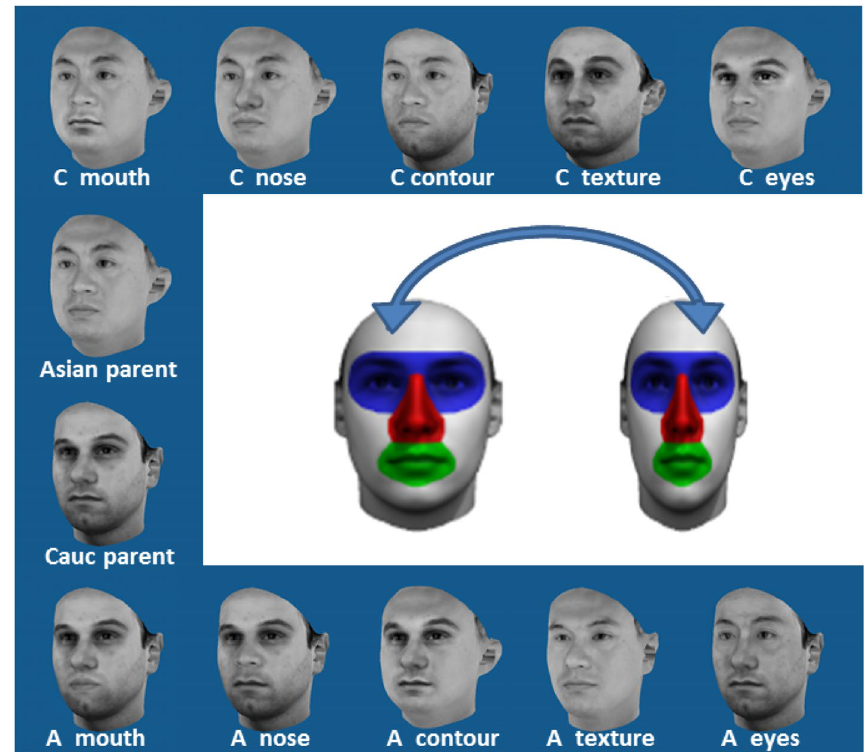
Figure 1. Example of face images derived from one Asian-Caucasian face pair (blue background images). Here only one of two face orientation is shown. A: Asian, C or Cauc: Caucasian. The top faces display the Asian parent faces with one Caucasian facial feature. The bottom faces display the Caucasian parent faces with one Asian facial feature. The central face pair on white background shows the facial regions (eyes: blue, nose: red, mouth; green, contour: grey) that were exchanged between faces. Texture (skin) was also exchanged between parent faces (as seen in A texture and C texture). The images were obtained using our in-house